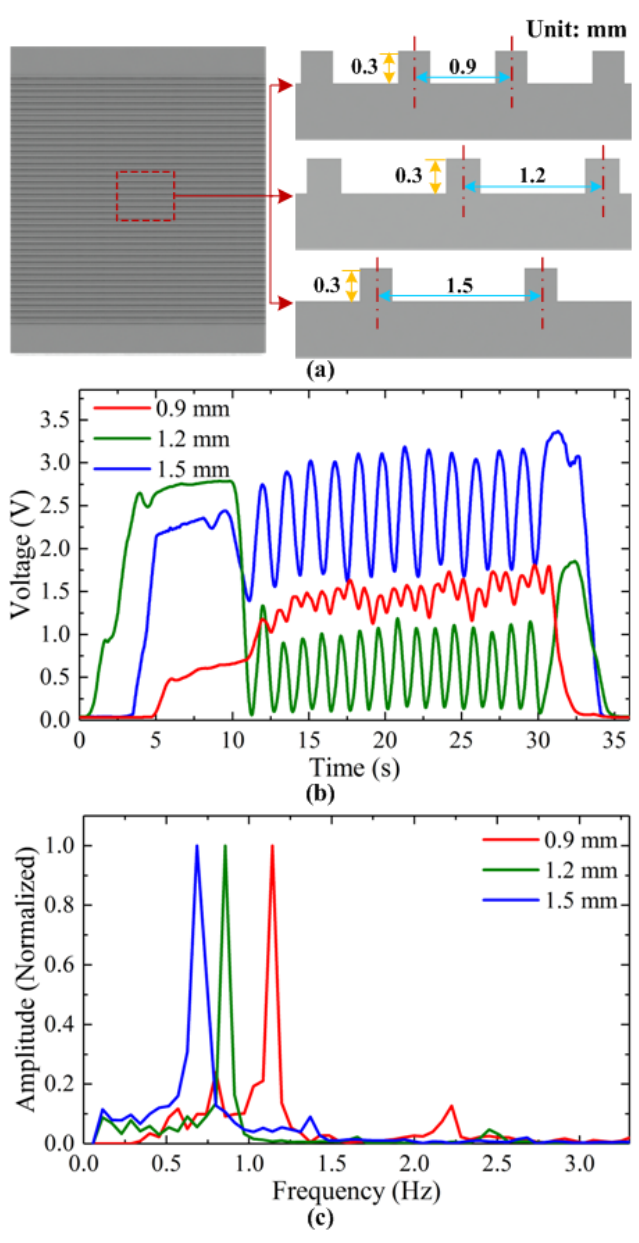
Figure 9. ( a ) Three grooved surfaces with different spatial periods of 0.9, 1.2 and 1.5 mm; ( b ) Measured voltage; ( c ) Spectrum analysis for surface texture recognition.